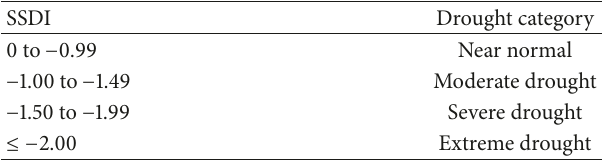
Table 4: Classification of the SSDI values and drought category. SSDI Drought category 0 to −